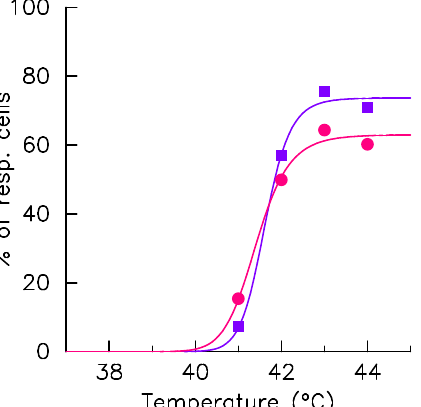
Figure 4. Fraction of responding cells. The HSF1:eGFP fluorescence and fraction of HSF1:eGFP fluorescence in nSBs ( F ) are monitored over time in a single cell upon a 41–44 ◦ C heat stress, time zero coincides with the stress onset. The fraction of cells having detectable fluorescence foci during the hyperthermia phase (dots) are displayed as function of the exposure temperature in col+ (red) and in col − (blue) conditions. The solid lines, which correspond to the result of the adjustment by a Hill function, serve only as eye